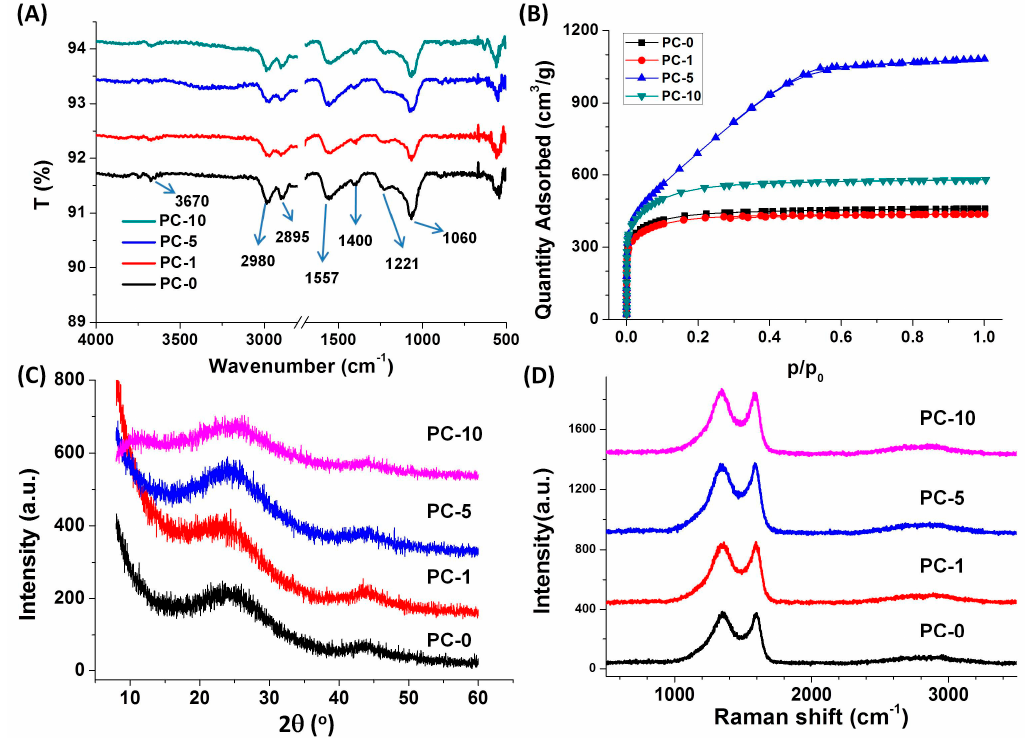
Figure 5. ( A ) The FT-IR (Fourier transform infrared) spectra, ( B ) N 2 adsorption-desorption isotherms, ( C ) XRD (X-ray diffraction) patterns, ( D ) The Raman spectra of the porous carbon materials.